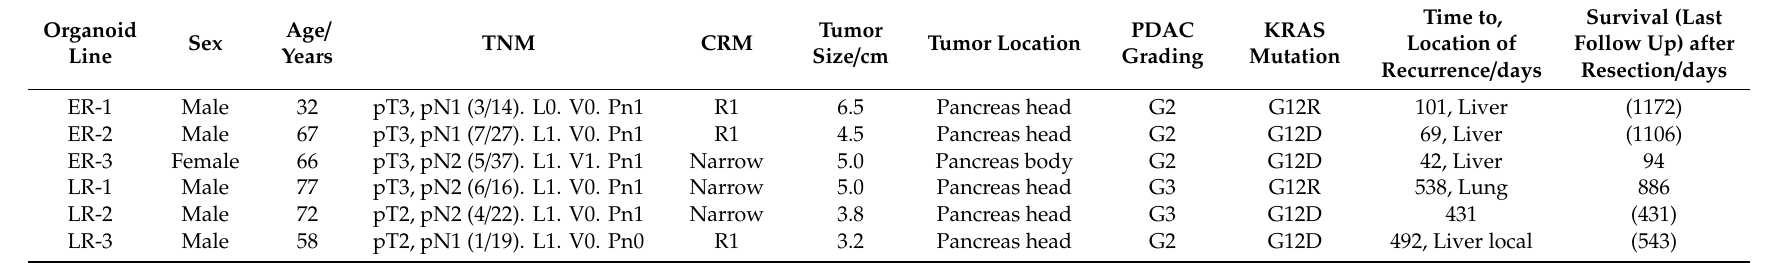
Table 1. Patient and clinical data of PDO lines used in this study. The table summarizes early recurrent (ER) and late recurrent (LR) patients data including sex and age, as well as clinical data including tumor grading, KRAS mutation and state of tumor recurrence. Patient ER-1 received three cycles FOLFIRINOX prior to resection, while all other patients did not receive any neoadjuvant